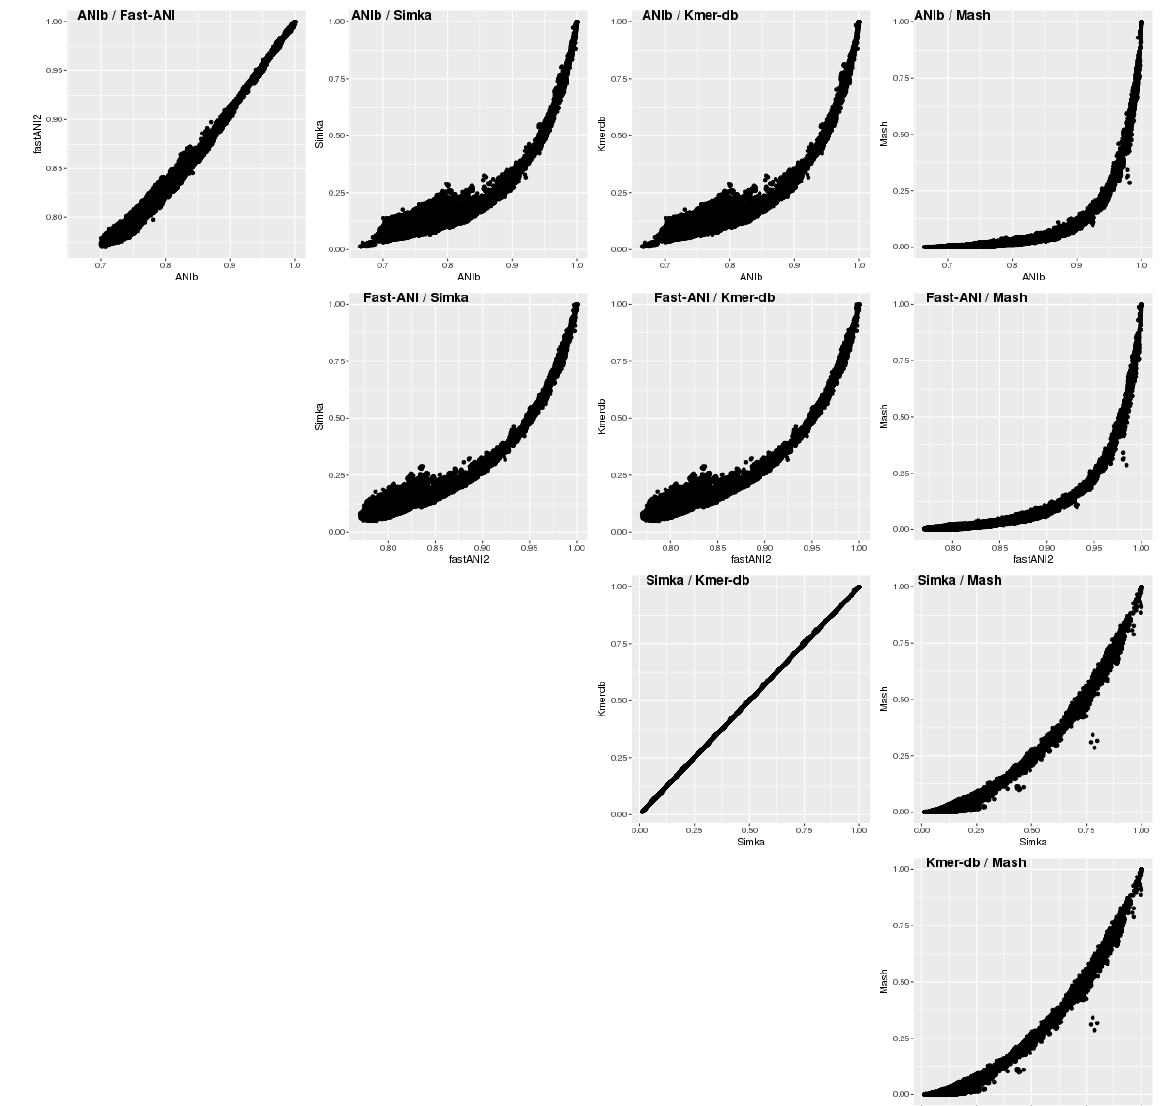
Figure 2. Comparison of average pairwise similarity between genomes sequences. Overall genome relatedness indexes of 934 Pseudomonas genomes sequences were calculated with PYANI (Pritchard et al. 2016) and four different k-mers indexing softwares: FastANI (Jain et al. 2018), Simka (Benoit et al. 2016), Kmer-db (Deorowicz et al. 2019) and MASH (Ondov et al.